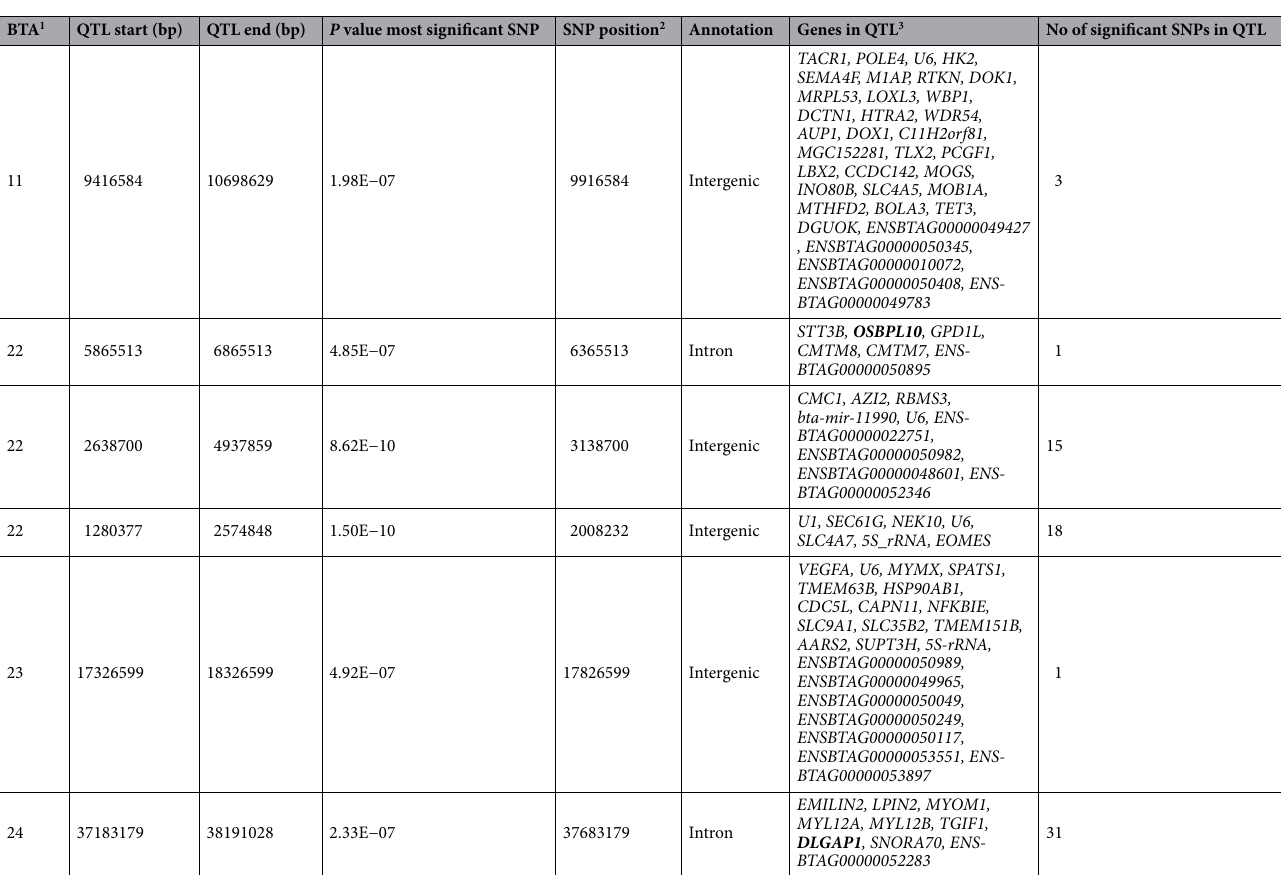
multifocal vs undetected lesions (λ median = 1.04401), and diffuse versus undetected lesions (λ median = 1.03222), indicating that significant values were not overestimated due to population stratification or cryptic relatedness.